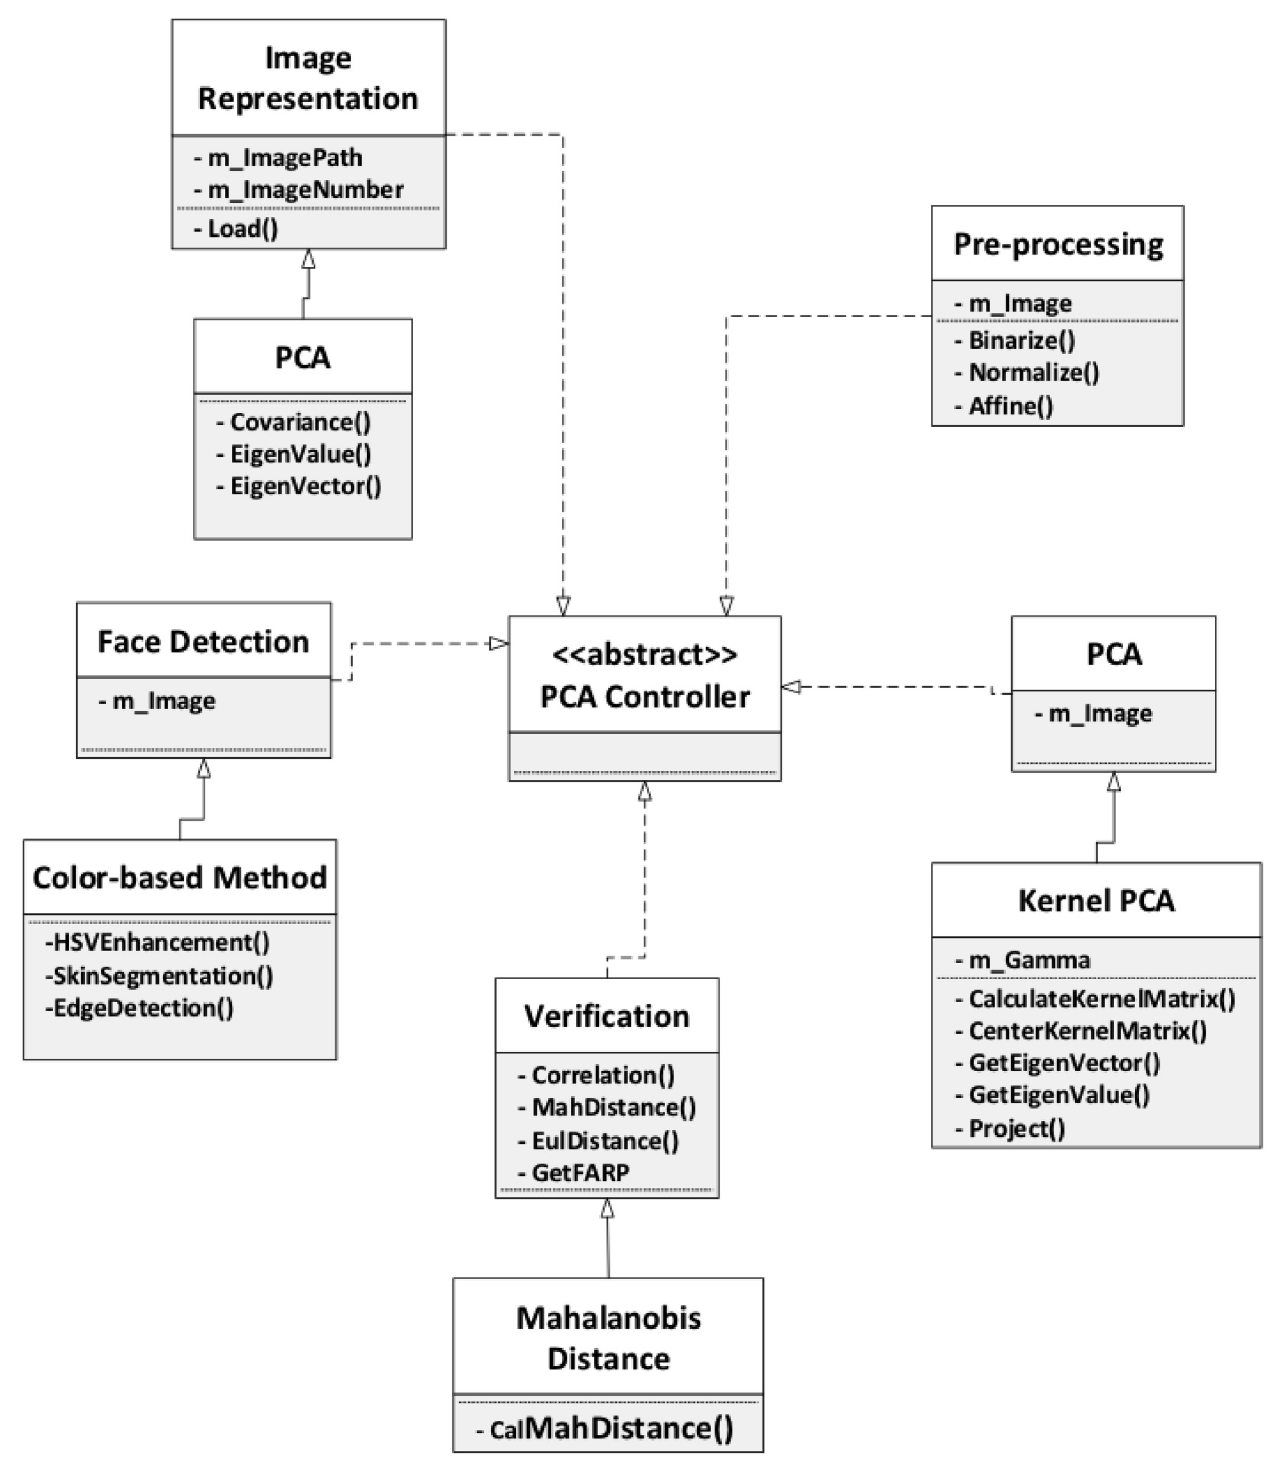
Fig 31. Case Study